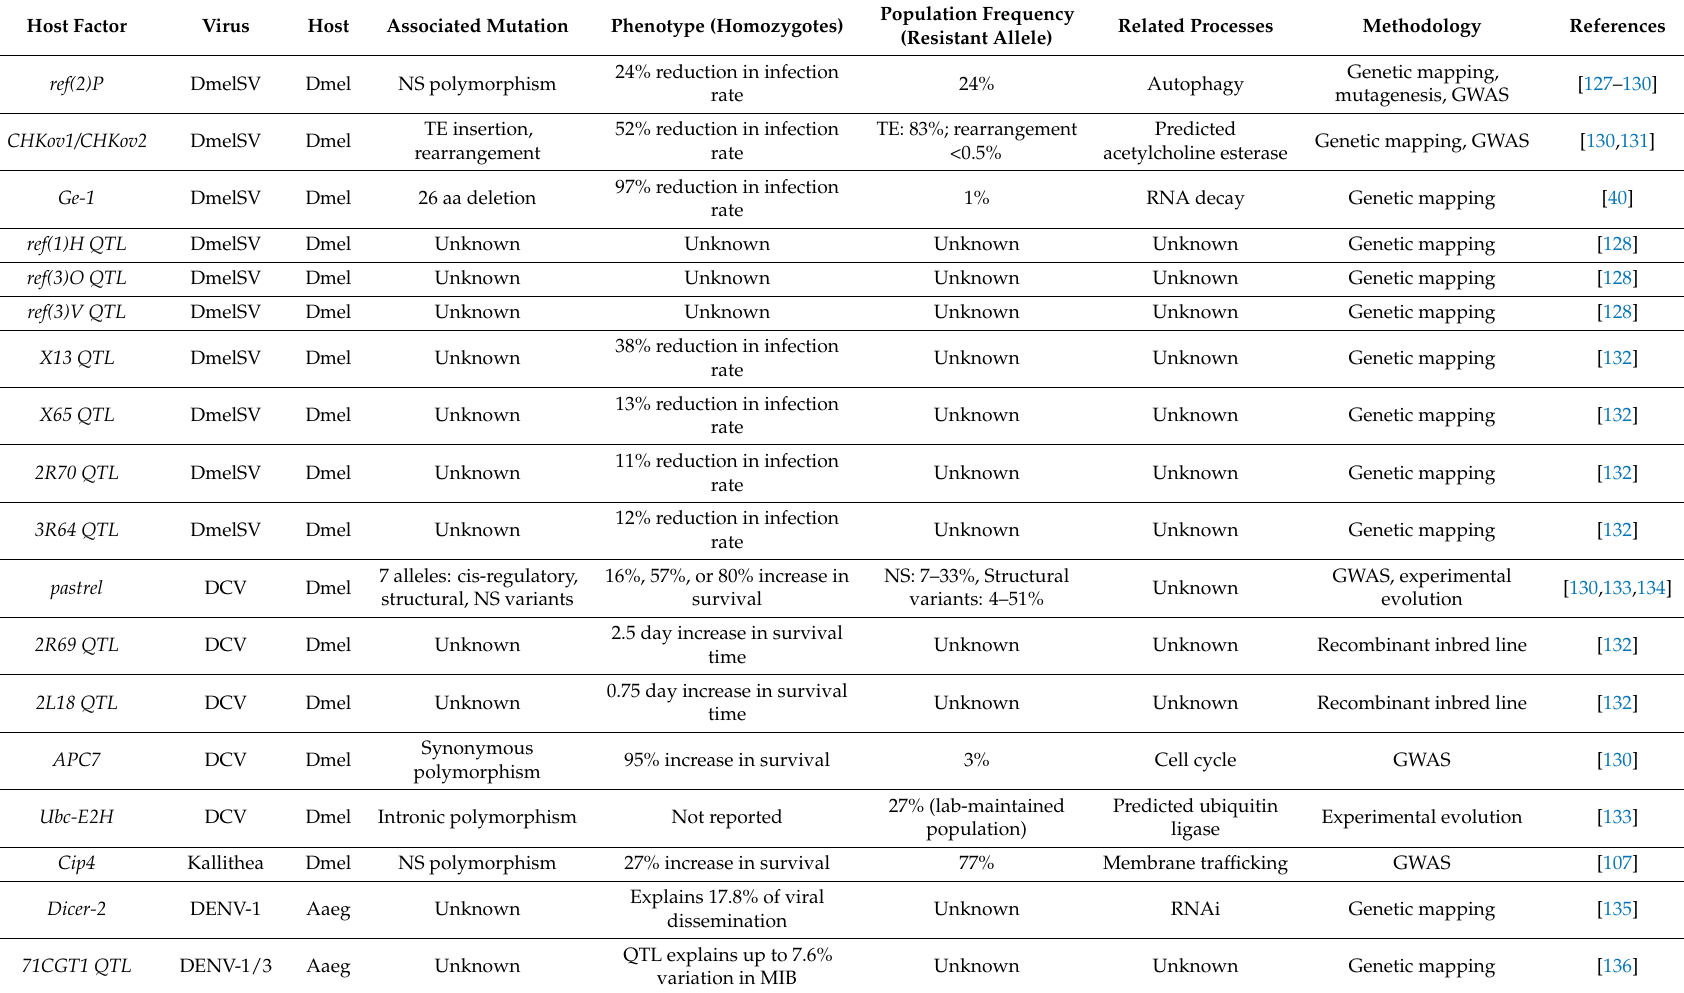
Table 2. Genetic variants associated with viral